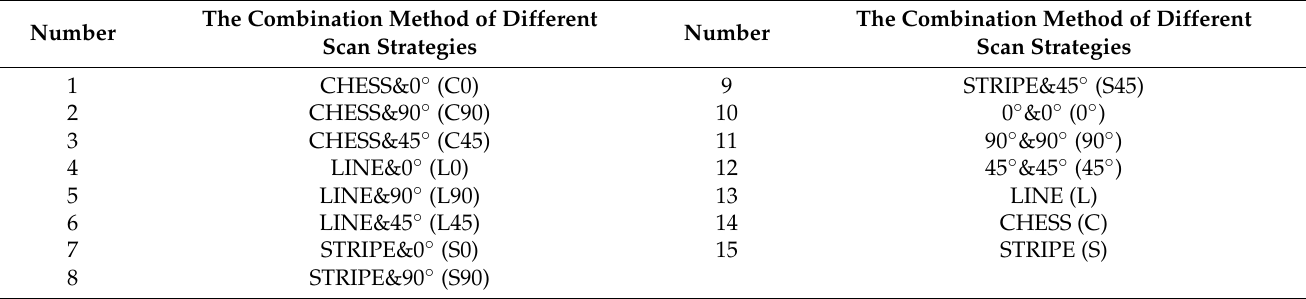
Table 3. Different L-PBF tensile specimen numbers and their scanning strategy